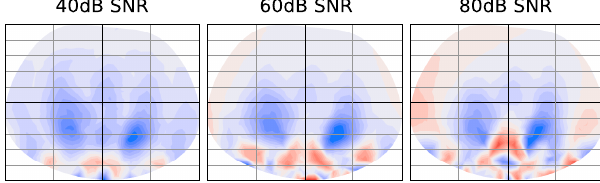
Fig.7: The reconstructed images due to the temporal conductivity changes during ventilation for diffenrent SNR levels. The slices correspond to the imaging plane.